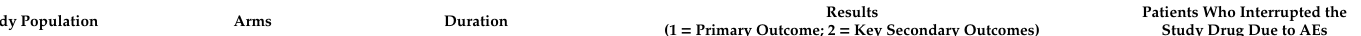
Results (1 = Primary Outcome; 2 = Key Secondary